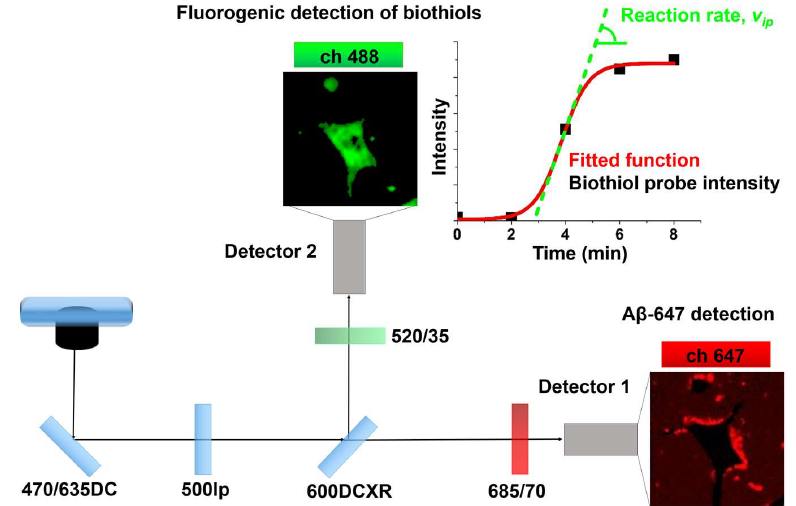
Figure 4. Scheme of the configuration of the dual-channel PIE-FLIM to simultaneously obtain Granada Green-2,4-dinitrophenylsulfonyl (GG-DNBS) biothiol probe and Aβ-647 aggregates images. For determining the rate of the fluorogenic biothiol reaction, the average pixel intensity in the regions of interest (black points) were fitted to a sigmoidal function (line red) and the slope at the inflection point (line green) was calculated.